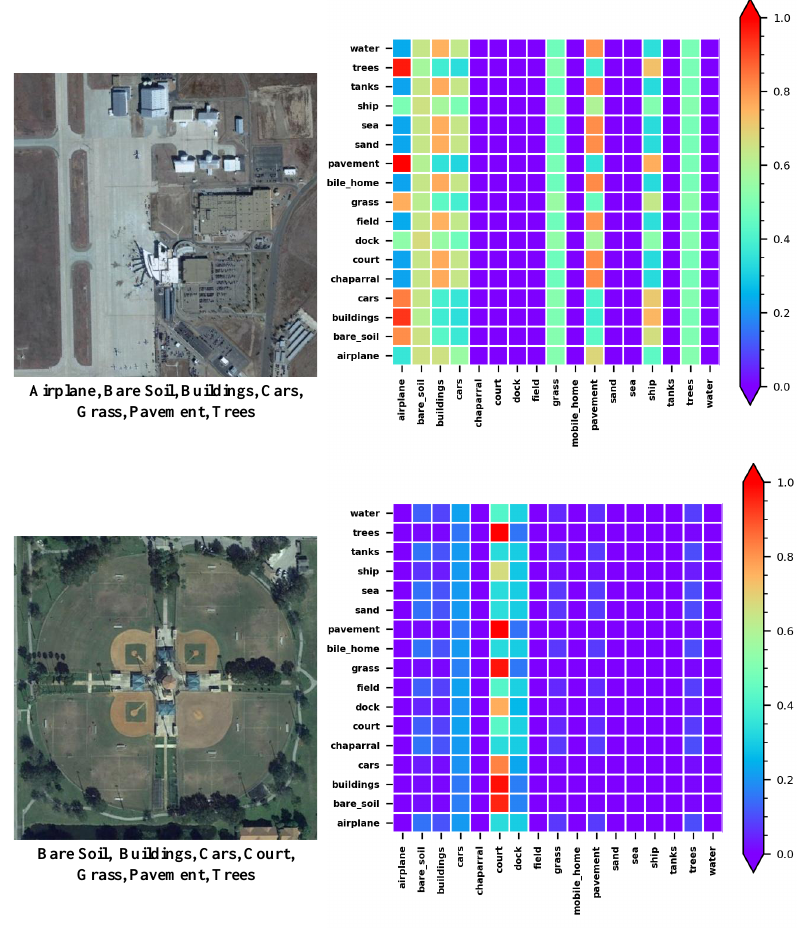
Figure 8. Visualization of the relation matrix in MAT on the AID Multi-label